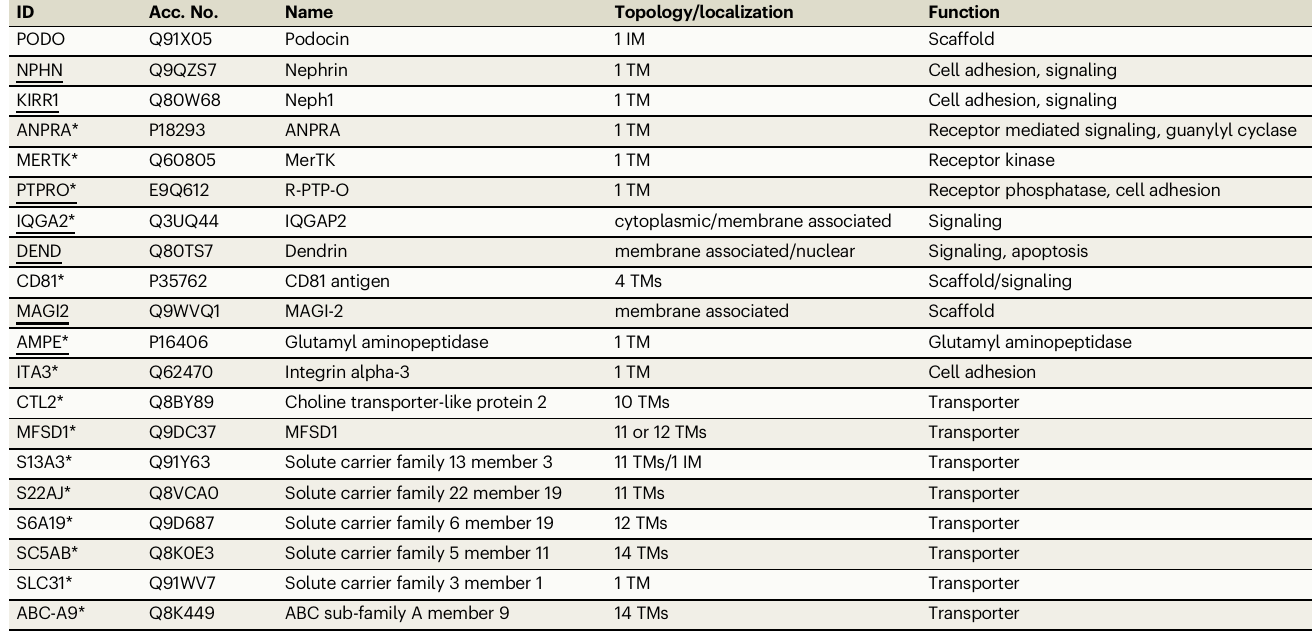
Table 2 | Constituents of the Podocin interactome determined by meAP-MS, together with annotation of subcellular locali- zation and primary function(s) indicated in literature and public databases ID Acc.